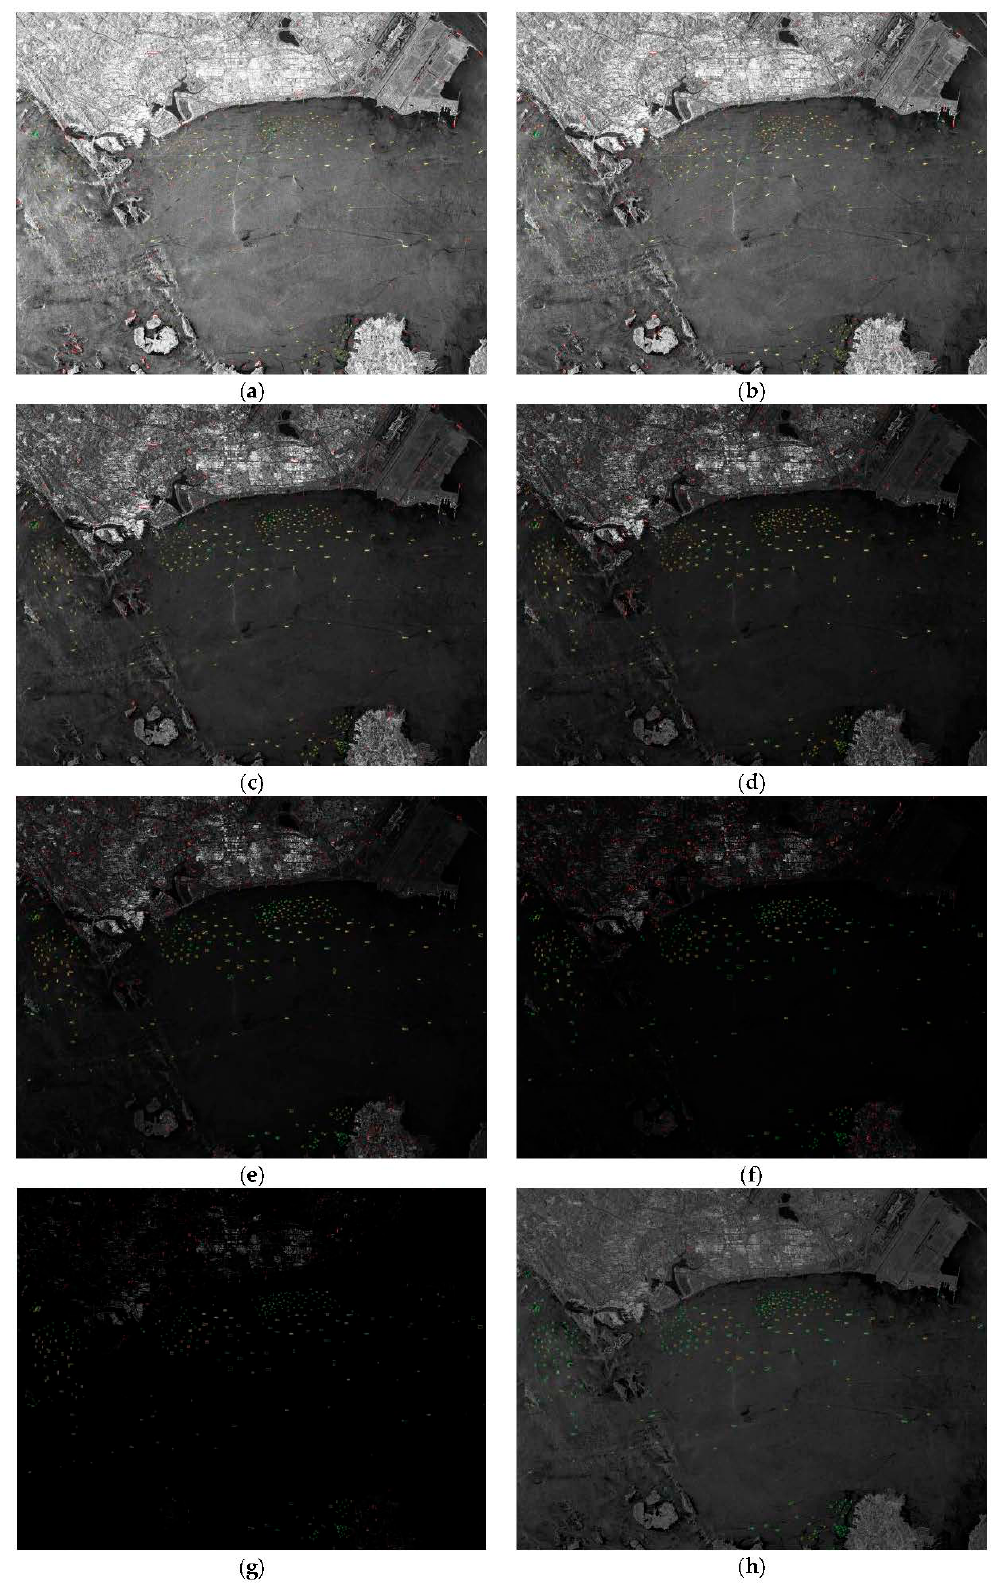
Figure 17. Ship detection results in the TerraSAR-X test image from the Strait of Singapore. ( a ) the result of 0.008; ( b ) the result of 0.01; ( c ) the result of 0.02; ( d ) the result of 0.03; ( e ) the result of 0.05; ( f ) the result of 0.1; ( g ) the result of − 20 dB; ( h ) the result of − 30 dB. Red boxes denote predicted results, and green boxes denote